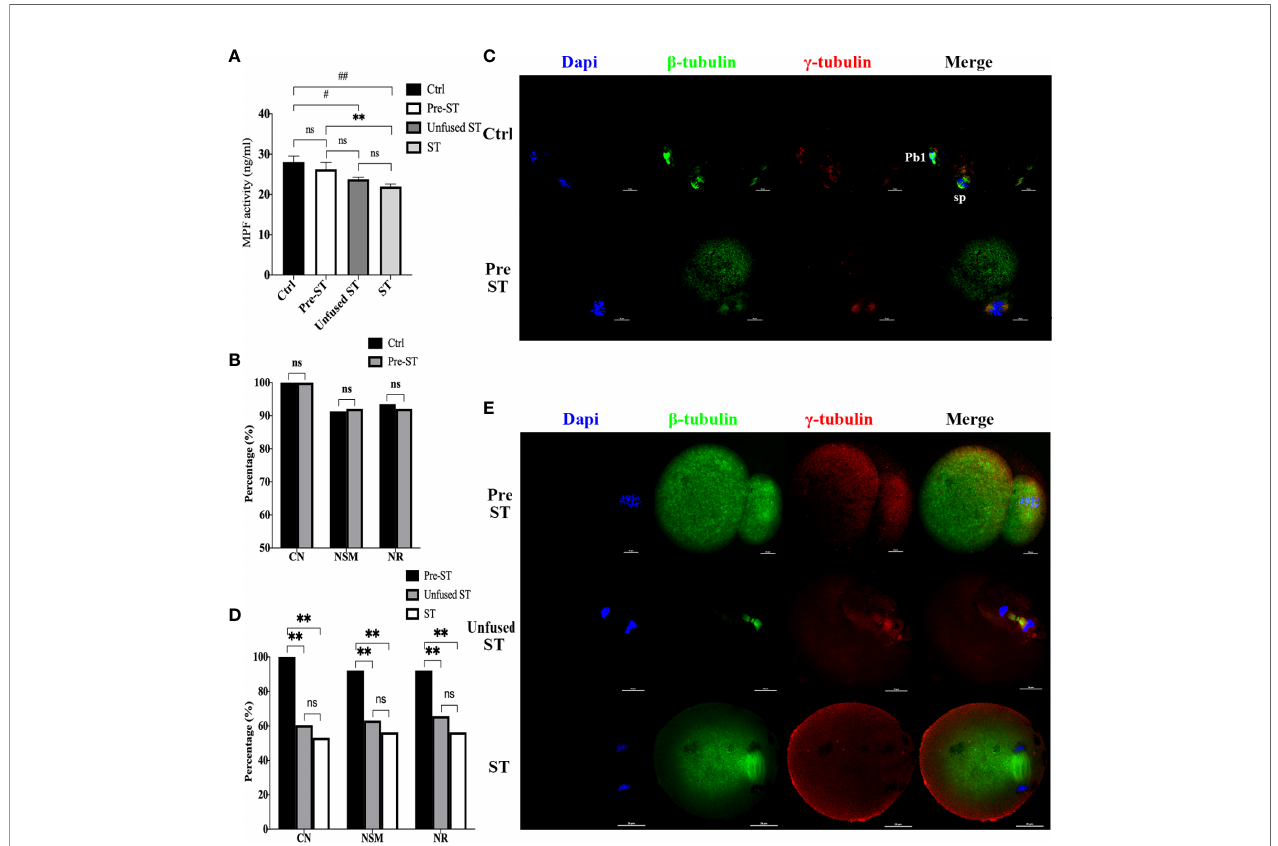
FIGURE 1 | Electrofusion stimulation rather than enucleation might be the key factor causing premature activation in ST reconstructed oocytes. (A) After electrofusion stimulation, MPF activity was signi fi cantly reduced whether fused or not. (Ctrl, the control group, Pre-ST, the reconstructed oocytes before electrofusion group, Unfused ST, the unfused ST reconstructed oocytes group, ST, the fused ST reconstructed oocytes group). # P<0.05, ## P<0.01, **P<0.01, ns P>0.05. Data is the MPF activity per 100 oocytes (ng/ml), expressed as mean ± standard deviation. (B) Enucleation did not cause abnormal chromosomes activity and spindle organization during meiosis. CN, chromosomal nondisjunction rate. NSM, normal spindle morphology rate. NR, normal g -tubulin rate. ns P>0.05. Data is expressed as a percentage (%). Immuno fl uorescence staining results in (C) con fi rmed that the chromosome arrangement, spindle morphology, and g -tubulin localization were normal in both groups. (Pb1, fi rst polar body; sp, spindle). (D) Electrofusion stimulation, whether fused or not, would cause abnormal chromosomes activity and disrupted spindle organization during meiosis. Data is expressed as a percentage (%). **P<0.01, ns P>0.05. (E) Immuno fl uorescence staining. In Pre-ST, the chromosome arrangement, spindle morphology, and g -tubulin location were all normal. In unfused ST, the chromosomes were separated to both poles of the spindle, with disordered arrangement. Spindle morphology was abnormal and g -tubulin localization was disrupted. In the ST group, chromosomes were separated to both poles of the spindle. The spindle morphology was normal, while the g -tubulin localization was disordered and scattered into the cytoplasm. DAPI labeled chromosomes (blue), anti- b -tubulin antibody coupled to FITC labeled spindles (green), and anti- g -tubulin antibody coupled to DyLight 594 labeled g -tubulin (red). Scale bar, 20 m